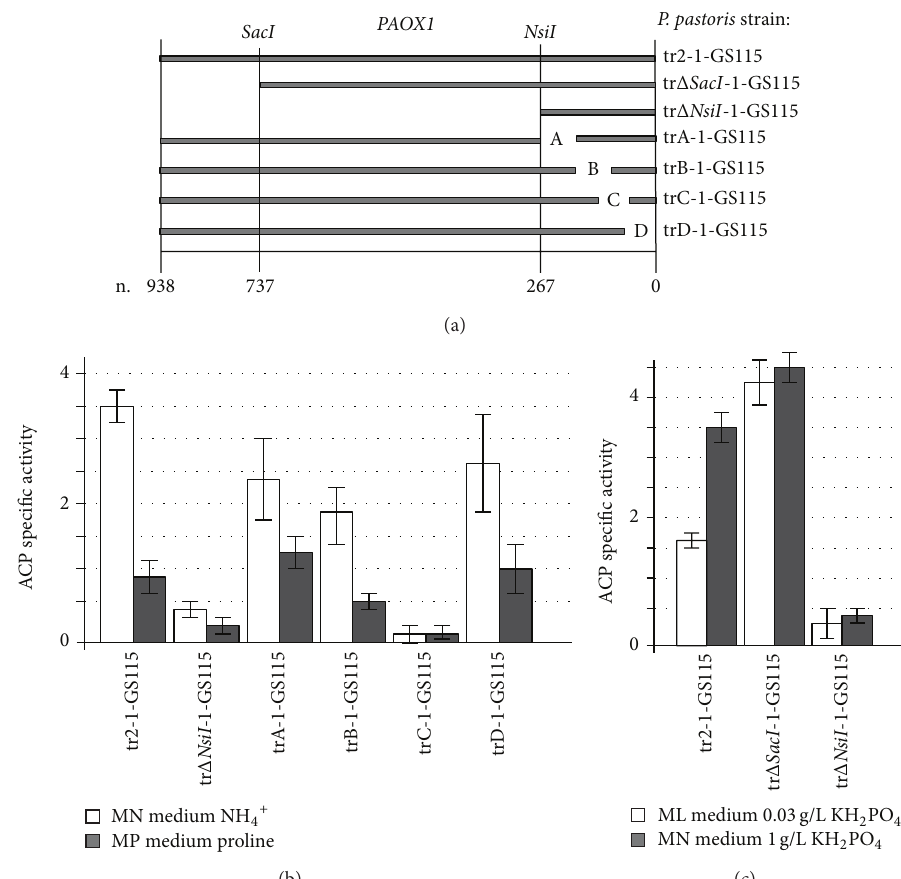
Figure 4: (a) Strains created in this study carry PHO5 reporter gene under control of different variants of AOX1 promoter: tr2-1-GS115 carries a native promoter, tr Δ SacI -1-GS115—a variant truncated in SacI site ( − 737), tr Δ NsiI -1-GS115—a variant truncated in NsiI site ( − 267), trA-1- GS115 carries AOX1 promoter with deletion from − 296 to − 216, trB-1-GS115 from − 222 to − 188, trC-1-GS115 from − 205 to − 45, and trD-1-GS115 from − 80 to − 0 nucleotides. (b) ACP specific activity of P. pastoris strains trA-1-GS115, trB-1-GS115, trC-1-GS115, trD-1-GS115, and tr2-1-GS115 in media with different nitrogen sources (MN with ammonium sulphate and MP with proline). (c) ACP specific activity of P. pastoris strains tr Δ SacI -1-GS115, tr Δ NsiI -1-GS115, andtr2-1-GS115 in media with different concentrations of KH 2 PO 4 (MN with 1g/L and in ML with 0,03